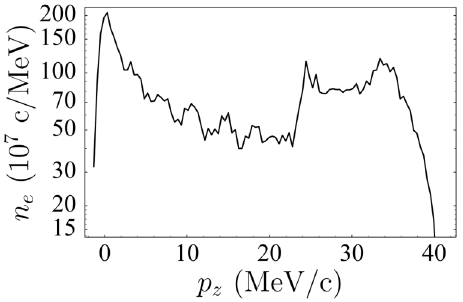
FIG. 14. Final energy distribution for a beam with an initially exponential energy decay law and a longitudinal z (cid:6) p correlation. Initial parameters: total charge Q (cid:1) 5 nC , tempera- (cid:1) 4 MeV , radius a (cid:1) 6 (cid:4) m , half-length a ture T e (cid:1) 2 mrad and divergence x 0 0